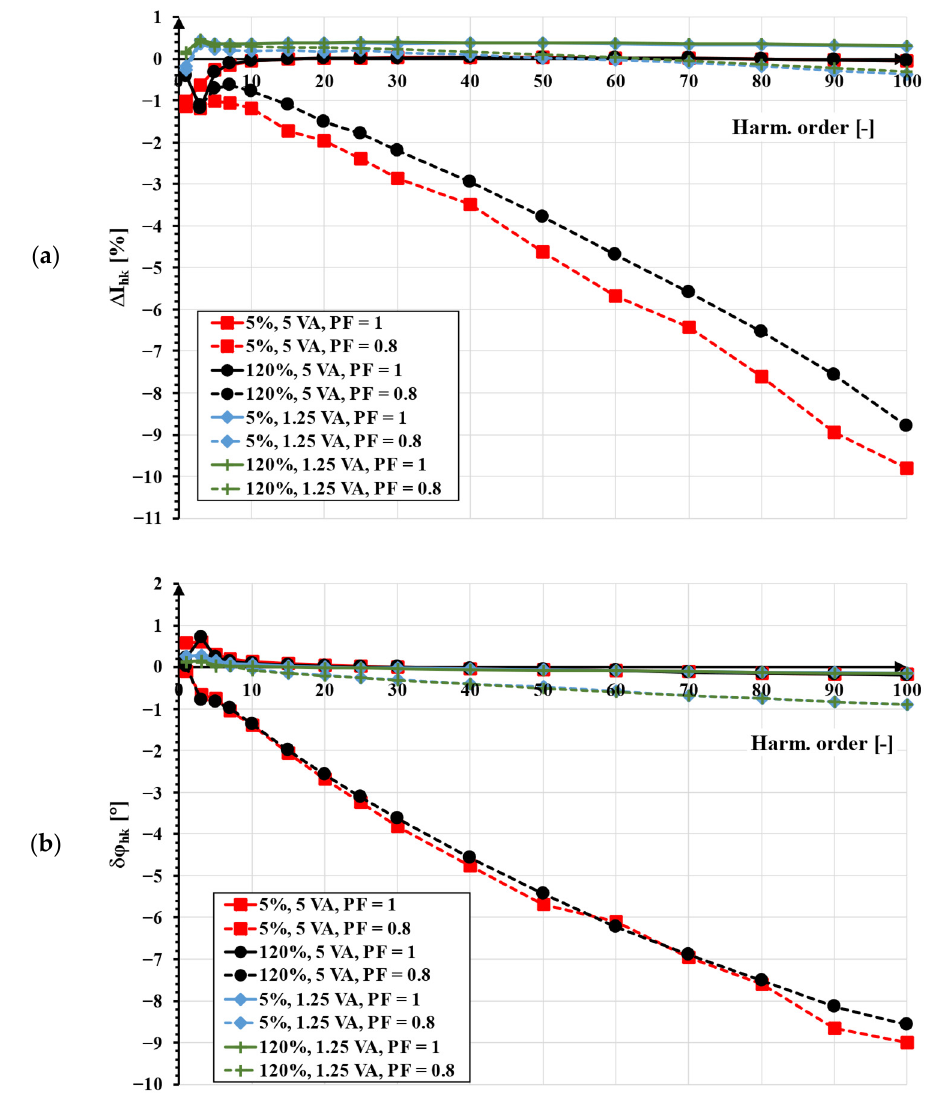
Figure 7. Comparison of the highest absolute values of ( a ) current error and ( b ) phase displacement determined for inductive CT 300 A/5 A with two values and power factors of the load [12].